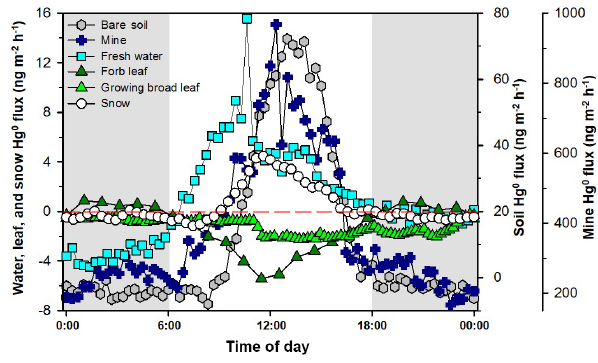
Figure 9. Diurnal patterns of Hg 0 flux from various environmen- tal compartments (soil, mine, freshwater, forb leaf, growing broad leaf and snow) measured using DFC methods. (Data obtained from soil: Zhu et al., 2015b; mine: Eckley et al., 2011a; fresh water: O’Driscoll et al., 2003; forb leaf: Stamenkovic et al., 2008; growing broad leaf: Fu et al., 2016; and snow: Maxwell et al.,